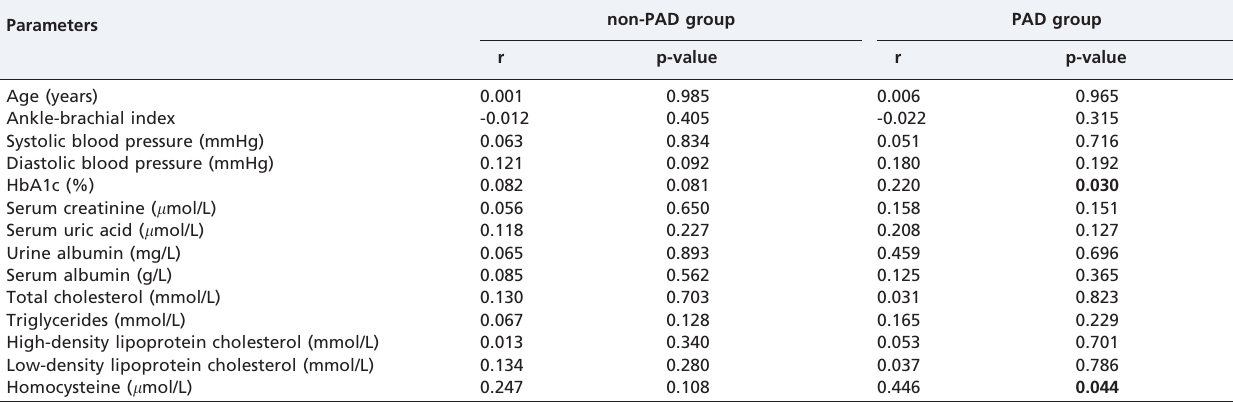
Table 2 - Correlations between the IMA and clinical parameters in the diabetic subjects.